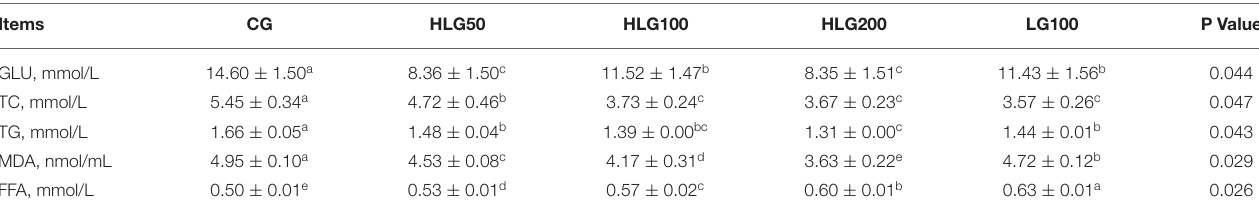
TABLE 8 | Effects of hydroxylated lecithin on other biochemical indicator levels related to lipid metabolism in serum of Jiangnan White goslings.